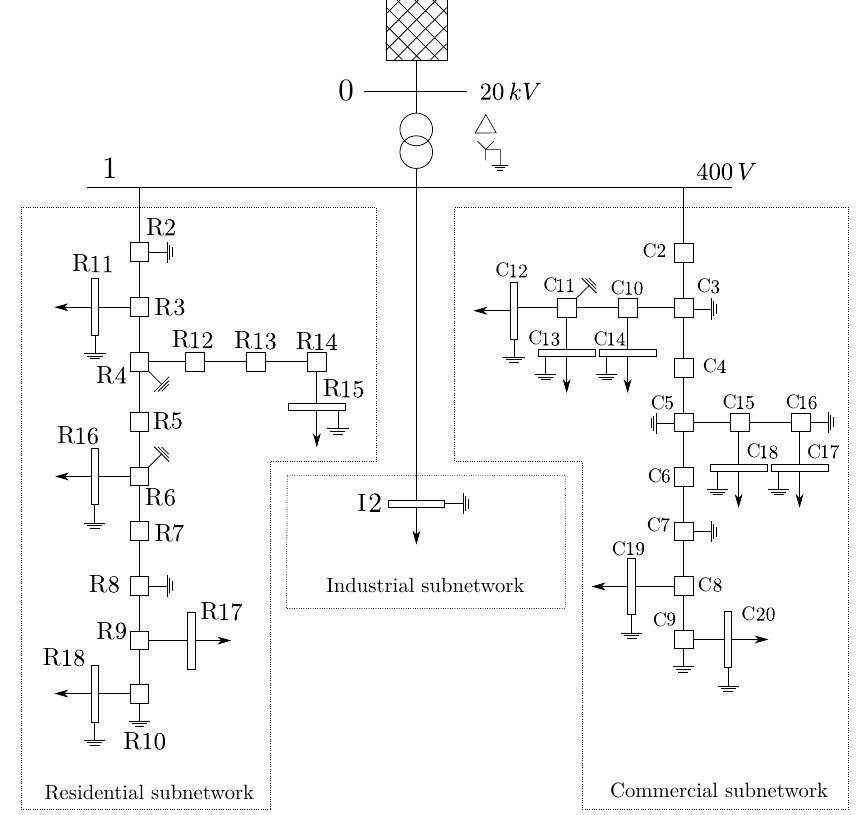
Figure 7. Modified European low-voltage benchmark network [48]. Table 1. Transformer parameters for the considered